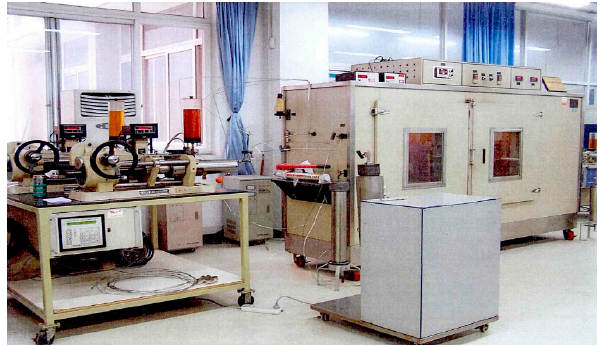
Figure 2. Core displacement system.